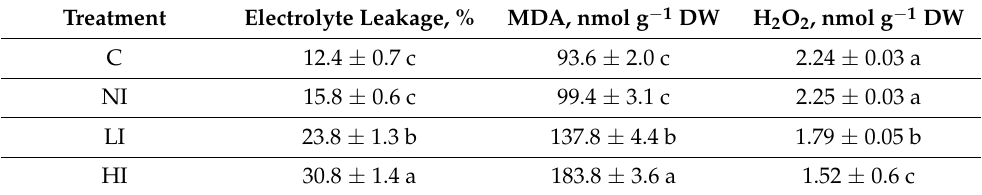
Table 2. Effect of mistletoe infestation on oxidative stress parameters in linden leaves.